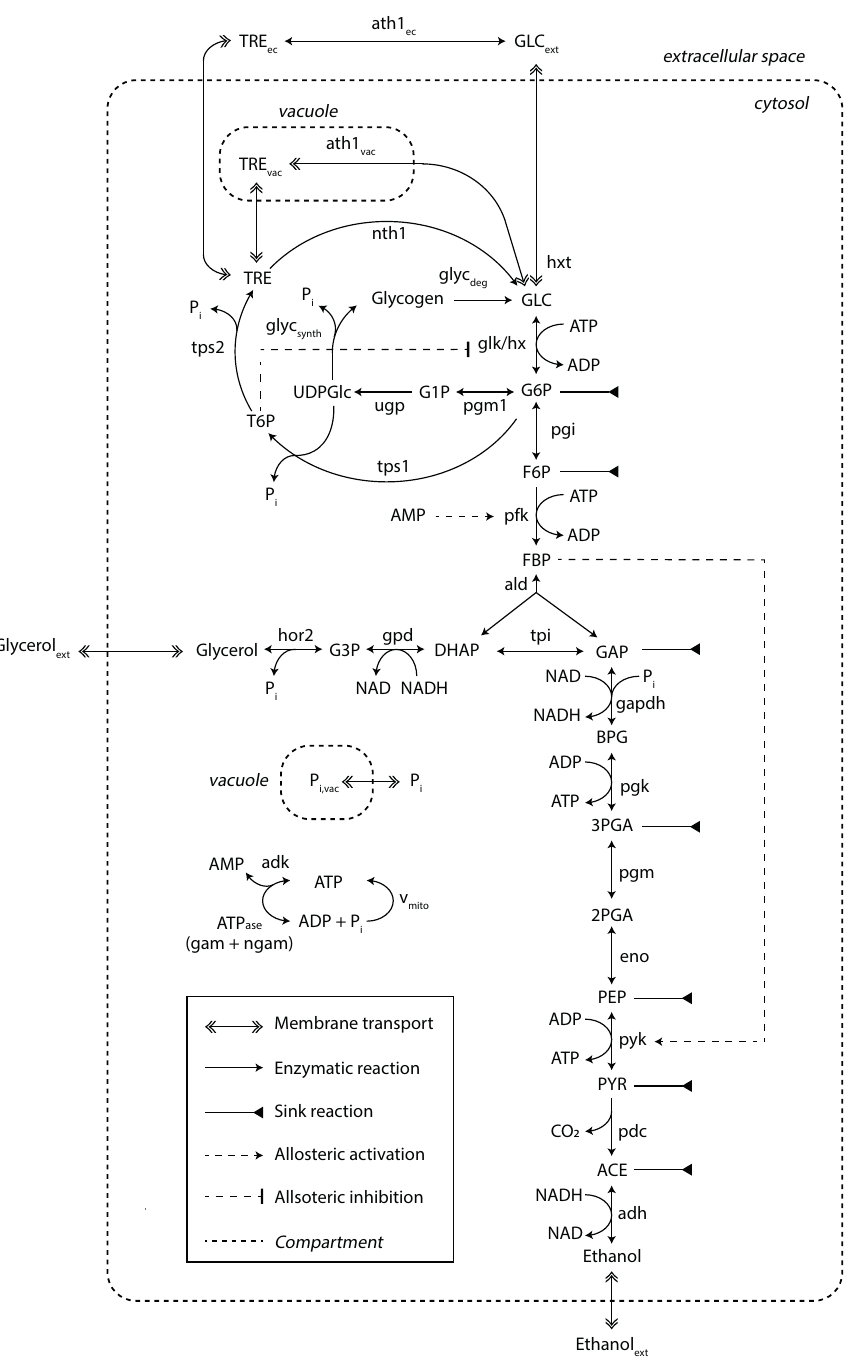
Figure 3. Kinetic metabolic model with a detailed description of trehalose and glycogen metabolism. Sink reactions account for fluxes towards the TCA, PPP and biomass synthesis. This model was adapted from [29]. The diagram style was adapted from [9]. For a detailed view on model mass balances and reaction kinetics, see Supplementary File